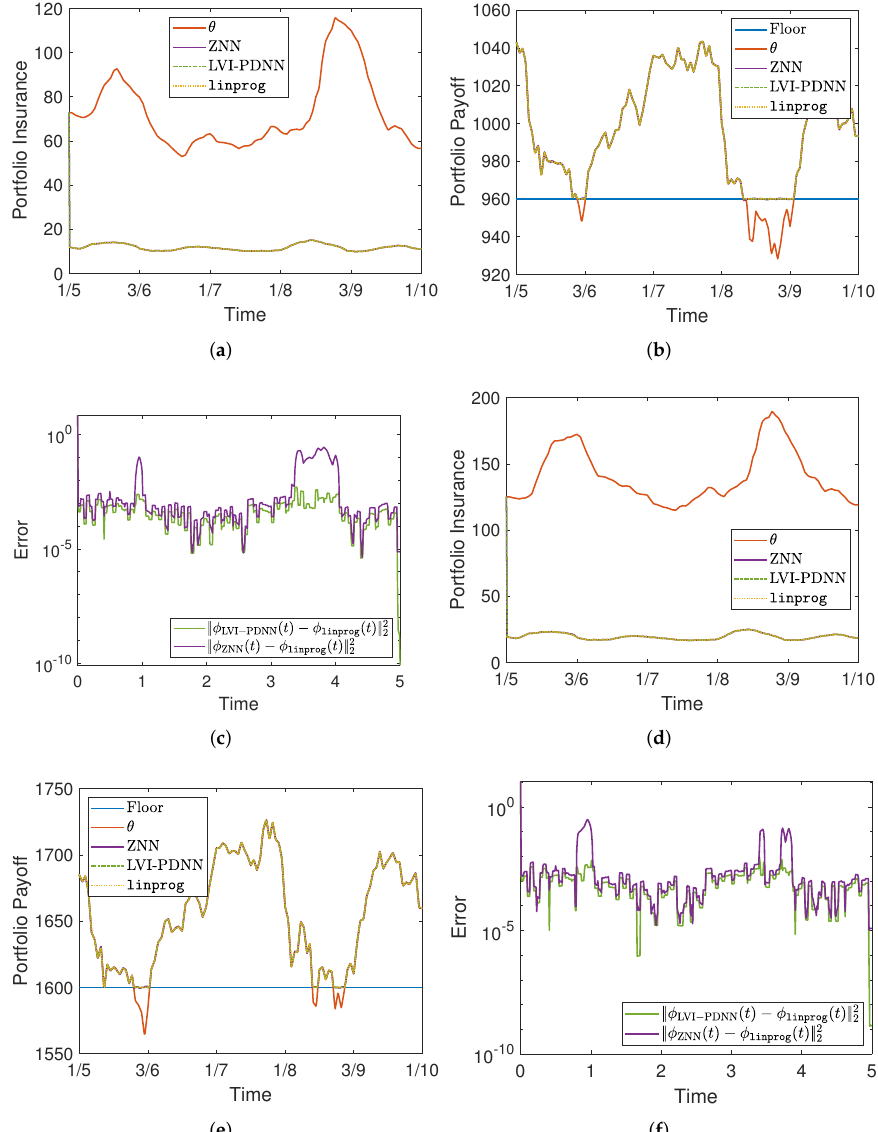
Figure 3. Portfolios’ weights, insurance costs, payoff, and the error between NNs and MATLAB’s linprog in cases 3 and 4. ( a ) Insurance costs (case 3); ( b ) portfolios’ payoff (case 3); ( c ) error: NNs